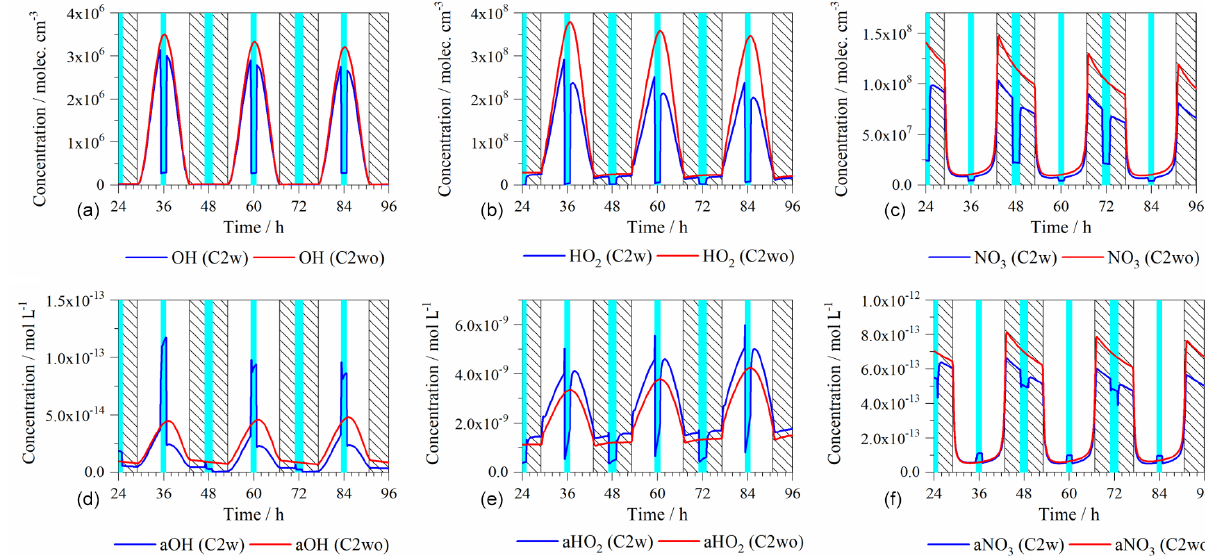
Figure 1. Time series of the modeled gas-phase ( a, b, c : molec.cm − 3 ) and aqueous-phase ( d, e, f : molL − 1 ) radical oxidant concentrations of the C2w and C2wo cases, respectively (light blue column: cloud; shadow: night; a: aqueous phase). For acronyms, see Table